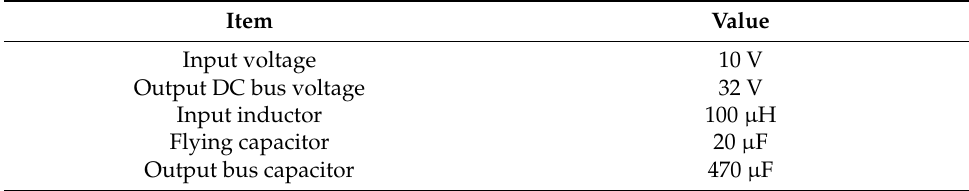
Table 2. The parameters of the prototype of flying capacitor DC/DC converter.